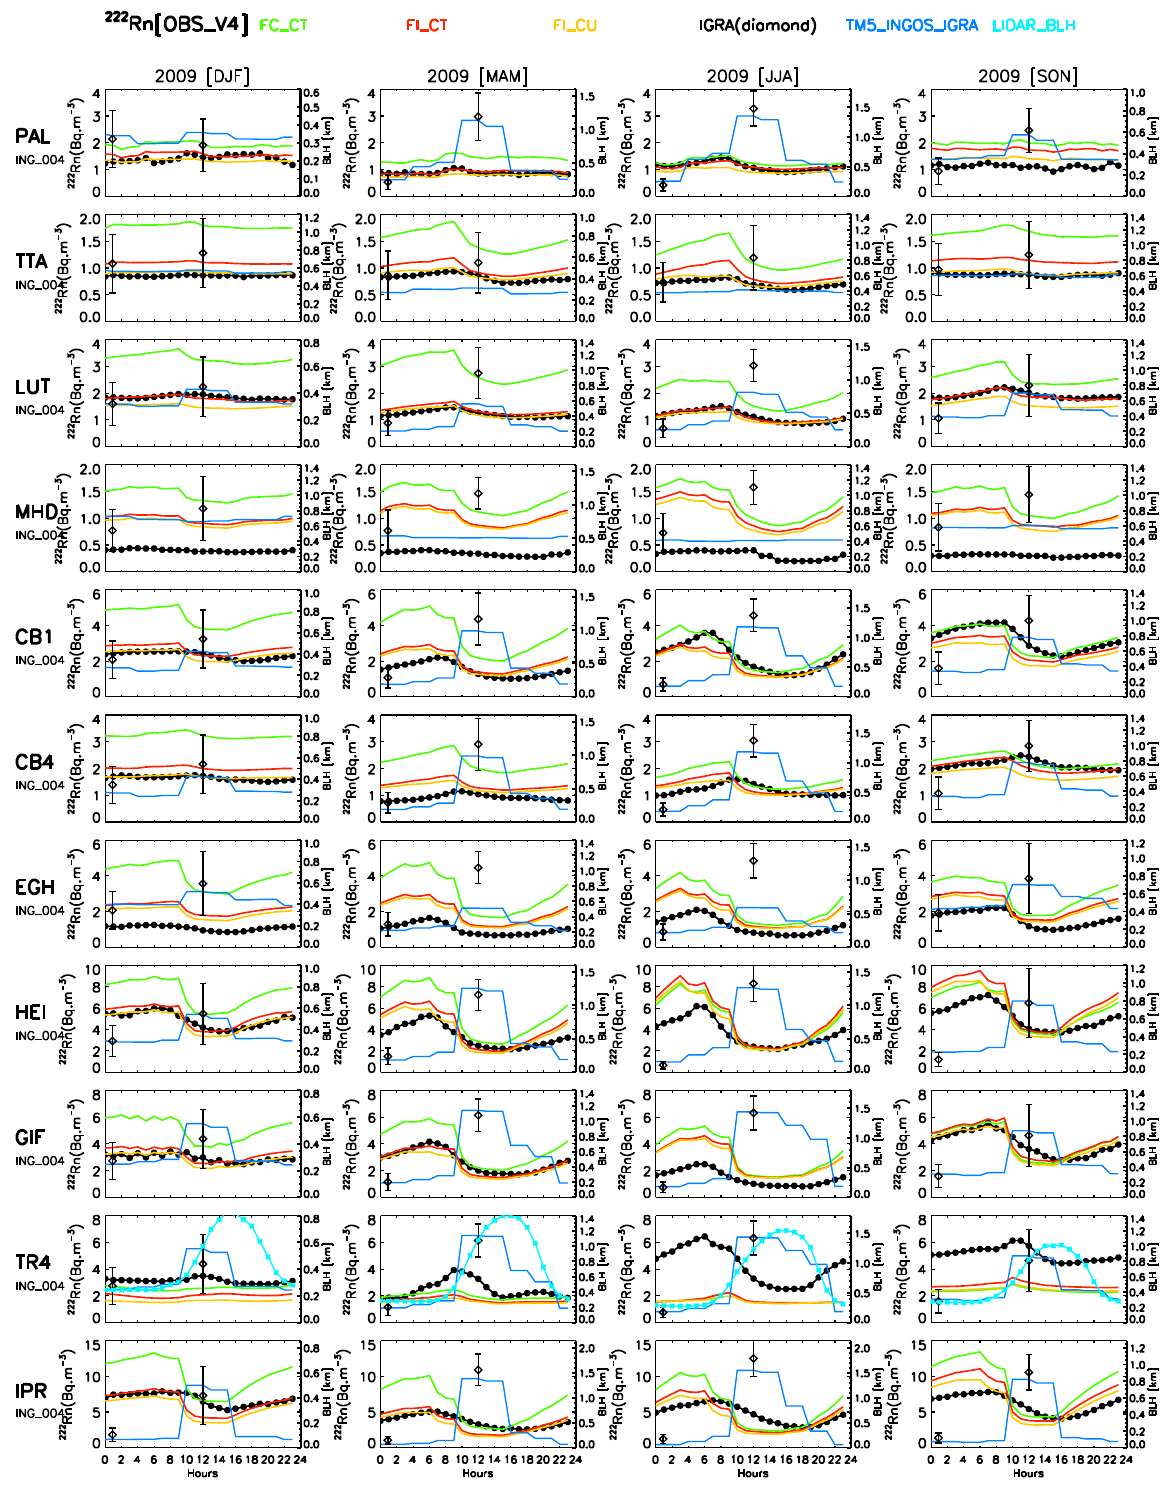
Figure 9. Seasonal variations of 222 Rn activity concentrations and boundary layer heights (BLHs) at the InGOS stations that measure 222 Rn activity concentrations. The observed concentrations are represented by the black solid line with dots. Three model simulations are considered: FC_CT, the model simulations using constant emissions; FI_CT using the InGOS emissions and the default convection scheme of TM5; FI_CU using the InGOS emissions and the combination of the “revised slopes scheme” and the new convection scheme based on ECMWF reanalyses. The BLHs of TM5 (TM5_INGOS_IGRA) are in dark blue, while observed IGRA BLHs at 00:00 and 12:00UTC are shown by the black diamonds together with their uncertainties. The lidar BLHs at Traînou (for 2011) are shown by the light blue line. Geosci. Model Dev., 9, 3137–3160, 2016